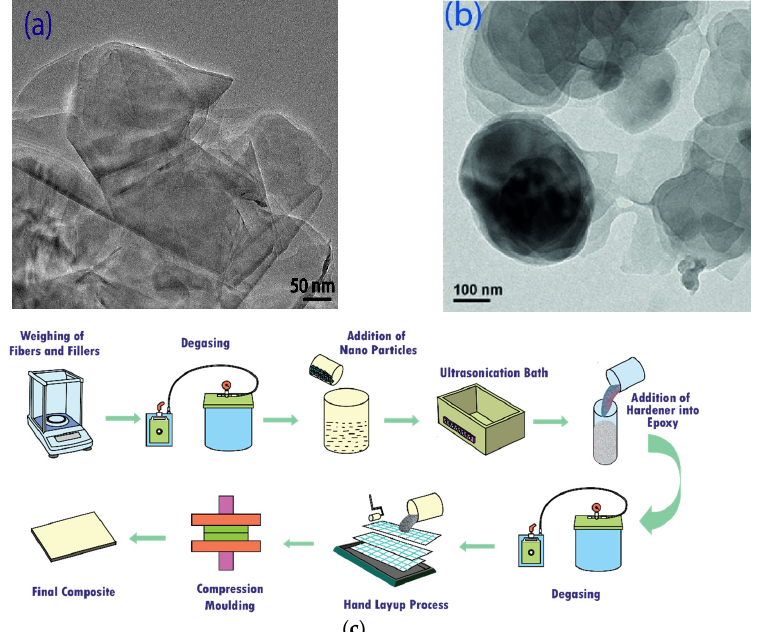
Figure 1. TEM images of ( a ) graphene and ( b ) hexagonal boron nitride (hBN). ( c ) Composite fabrication process. Table 1. ( a ). Specification material according to GNP wt.%. ( b ) Specification of material according to h-BN wt.%.